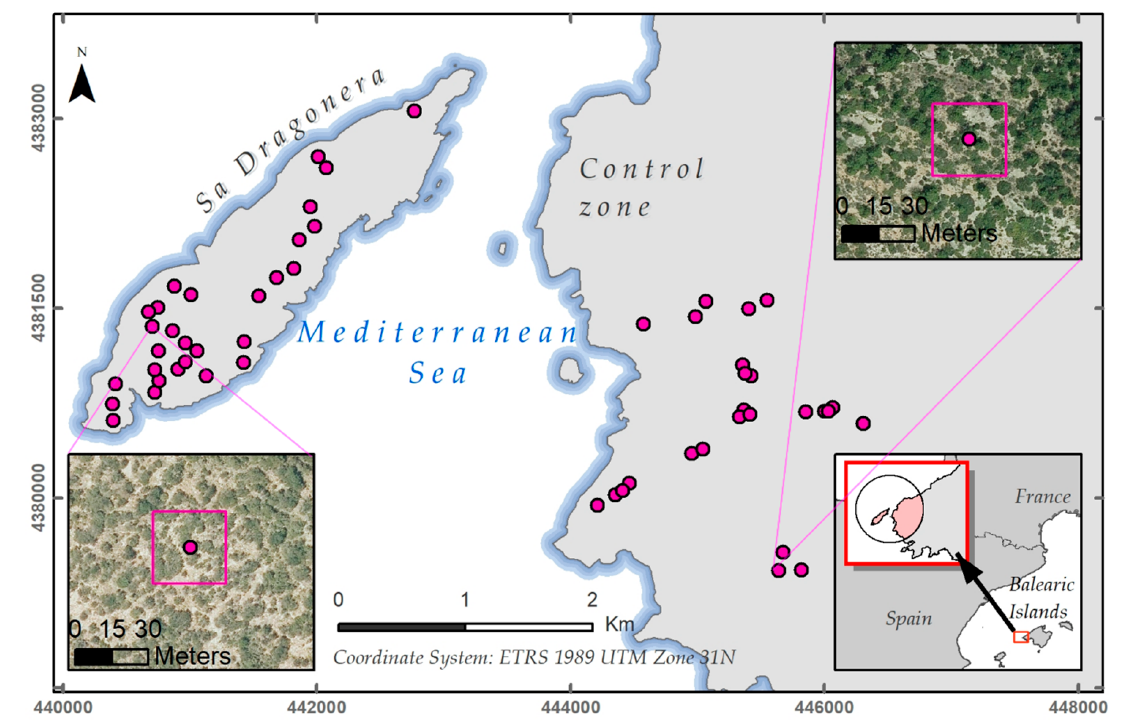
Figure 4. Map showing locations of selected sampling plots (pink dots) to create the NDVI time series for both treatments. On the left the sampling plots of Dragonera Islet (the treatment zone), on the right those of Mallorca Island (the control zone). High resolution aerial orthophotos (15 × 15 cm 2 ) show two examples of the 30 × 30 m 2 sampling plots of both treatments. Spatial reference map in the bottom right corner.